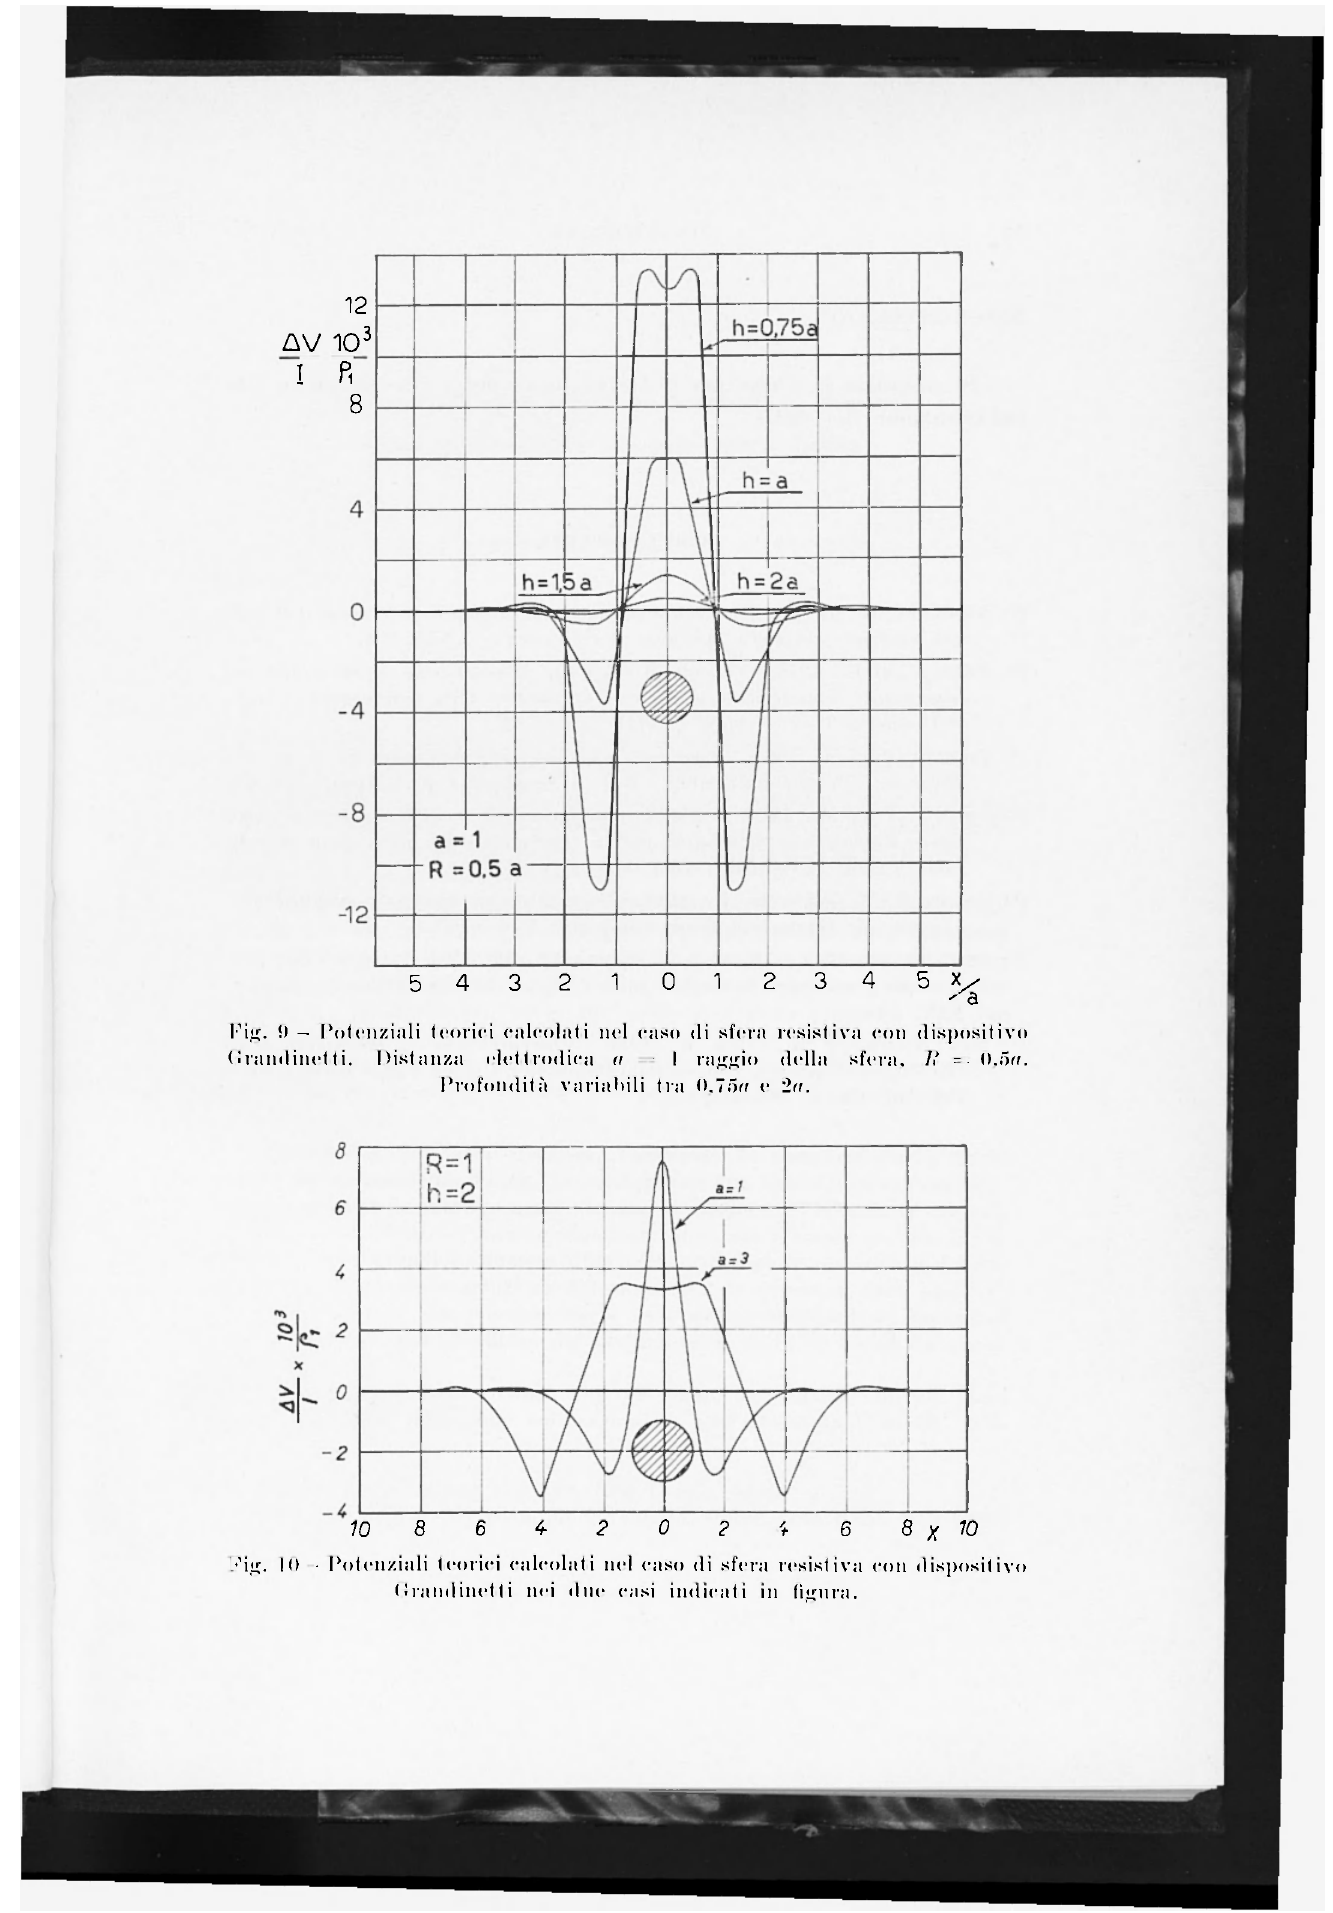
Fig. !) - Potenziali teorici calcolati nel caso (li sfera resistiva con dispositivo Orandinetti. sfera, li =•